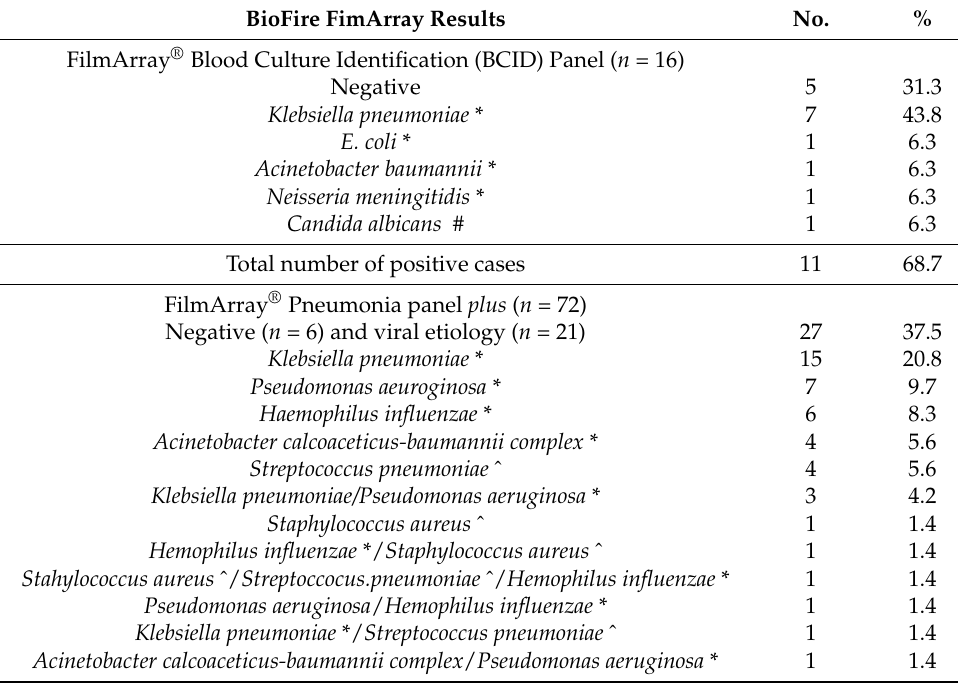
Table 2. Distribution of bacterial and fungal targets identified by the BioFire